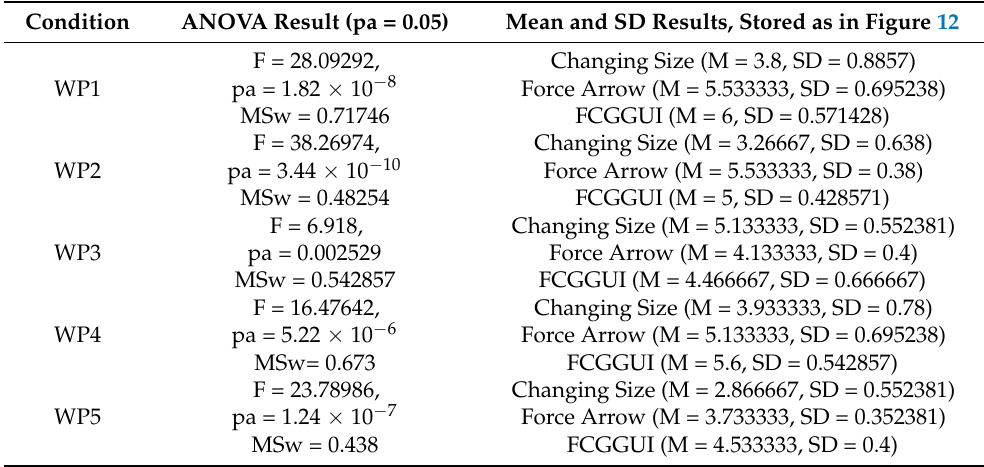
Figure 13. Results of the average points of questionnaires for the evaluation of weight perception. Table 6. Results of the ANOVA test of the weight perception in Experiment 1.